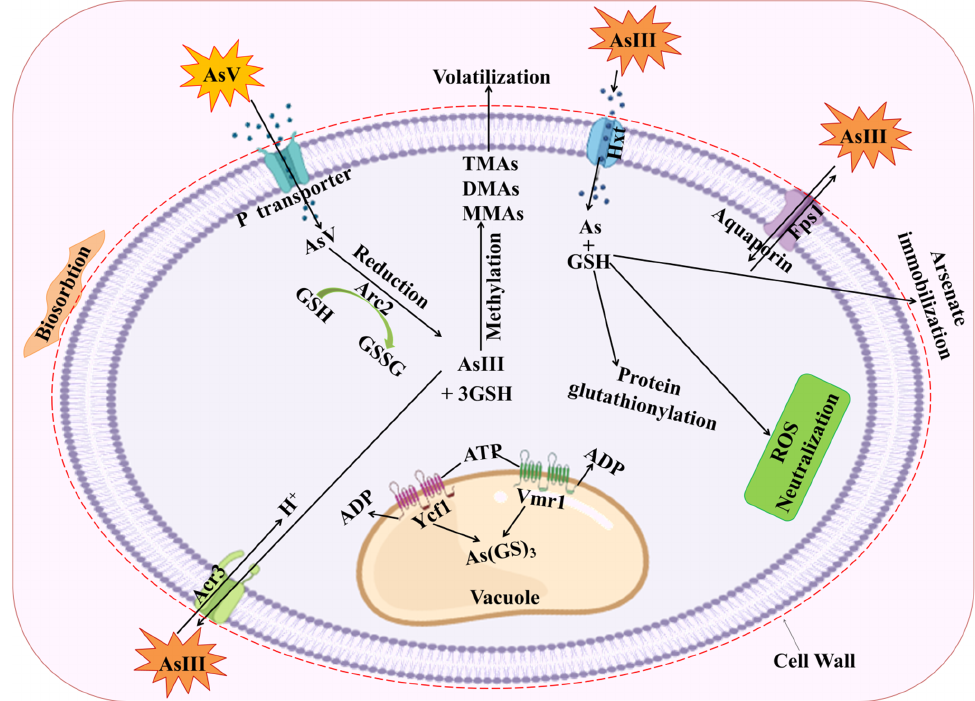
Figure 2. Detoxification mechanism of As toxicity via glutathione. AsV entry restricted through binding with carboxyl, amine, or other functional groups in fungal cell walls. AsV undergoes a quick enzymatic reduction to a trivalent state after entering the cytoplasm, making it a substrate for a variety of modifications and detoxification processes. Intracellular AsV is converted into AsIII, which is then transported or pumped outside of fungus cells. Arsenic is compartmentalized in the vacuole by the ABC transporters Ycf1 and Vmr1, generating As(GS) 3 . Methylation results in the production of less hazardous chemical compounds such MMAs, DMAs, and TMAs. Two genes, ACR2 that encodes an AsV reductase and ACR3 that encodes an AsIII exporter, may be expressed, which might trigger the tolerance to As exposure. AsIII methyltransferases are responsible for catalyzing the methylation process ( ArsMs ). The aquaglyceroporin Fps1 primarily facilitates AsIII uptake. Aquaglyceroporin Fps1 is primarily responsible for facilitating AsIII uptake, however AsIII can also enter cells through hexose permeases Hxt ( Hxt1-Hxt17, Gal2 ) in the absence of glucose. MMAs(III)—monomethylarsonic acid; DMAs—dimethylarsonic acid; TMAs—trimethylarsonic acid; GSH—glutathione; As(GS) 3 —arsenic